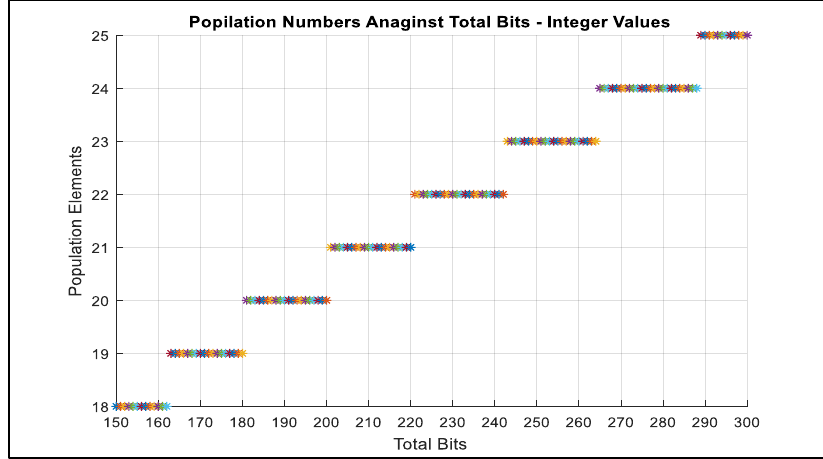
Figure 1. Growth of population size requirement with increasing chromosome bit size.